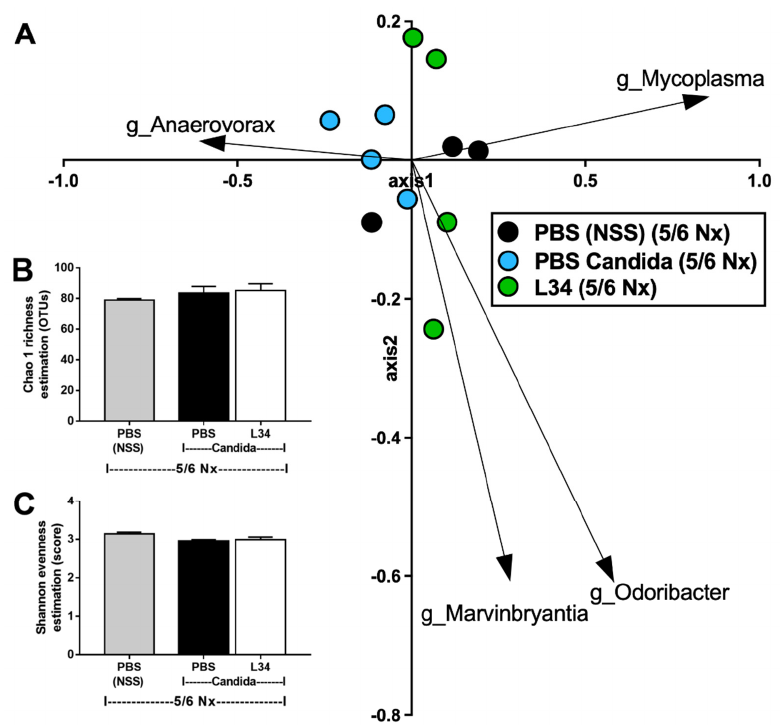
Figure 4. The fecal microbiome analysis 5/6 nephrectomy mice with phosphate buffer solution (5/6 Nx + PBS), Candida -administered 5/6 nephrectomy mice with Lacticaseibacillus rhamnosus L34 (5/6 Nx + Candida + L34) or with normal saline solution (NSS) control (5/6 Nx + Candida + NSS) as indicated by ( A ) the non-metric multidimensional scaling (NMDS); the alpha diversity: ( B ) microbial diversity of Chao and ( C ) Shannon estimation are